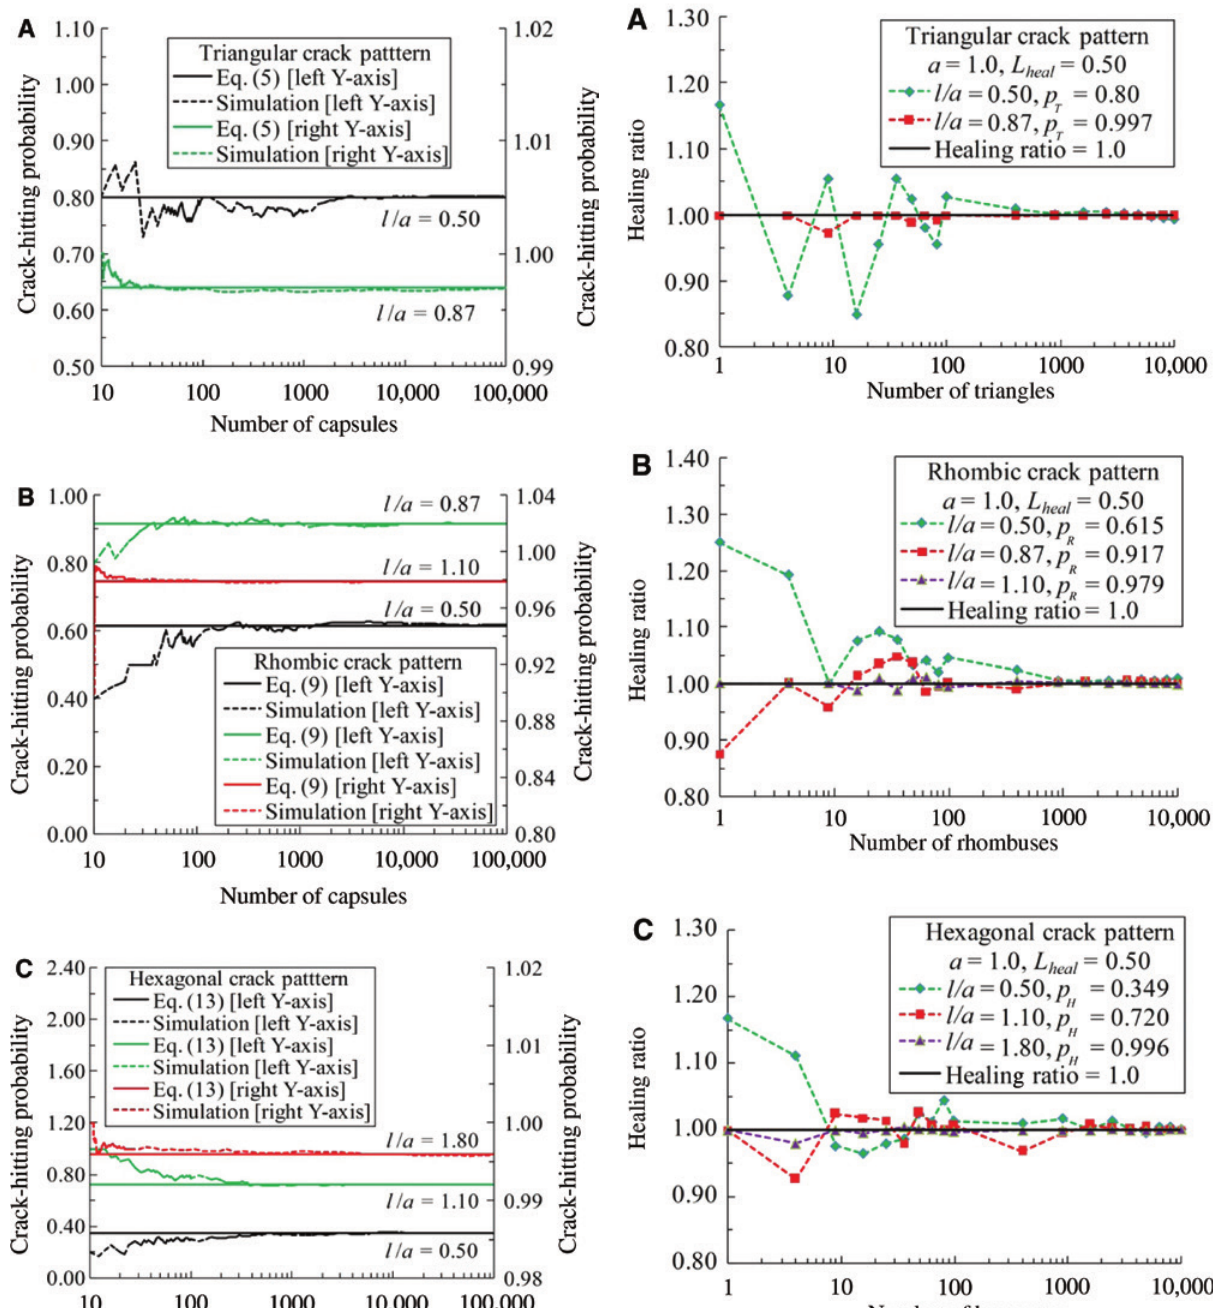
Figure 8: Verification of capsule dosage models for mono-shaped crack patterns: (A) triangular crack pattern, (B) rhombic crack pattern, and (C) hexagonal crack pattern.